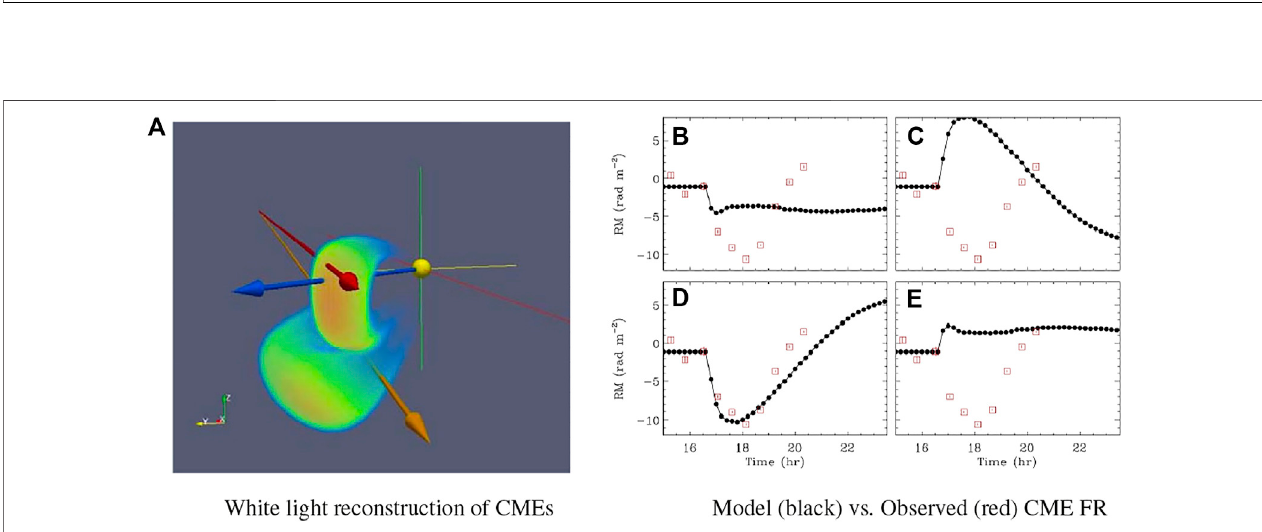
Frontiers in Astronomy and Space Sciences |